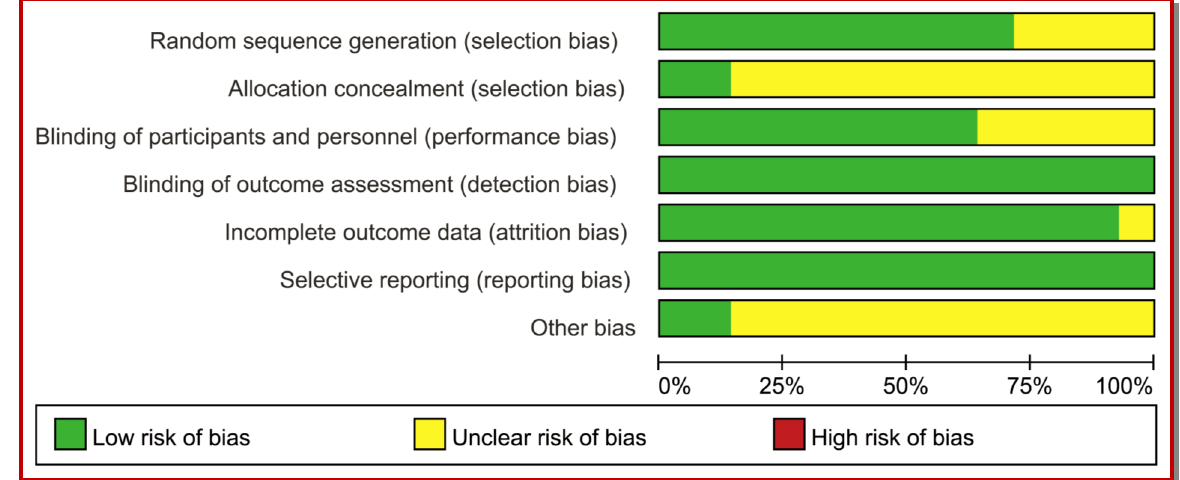
Figure 2: Quality assessment summary for all included